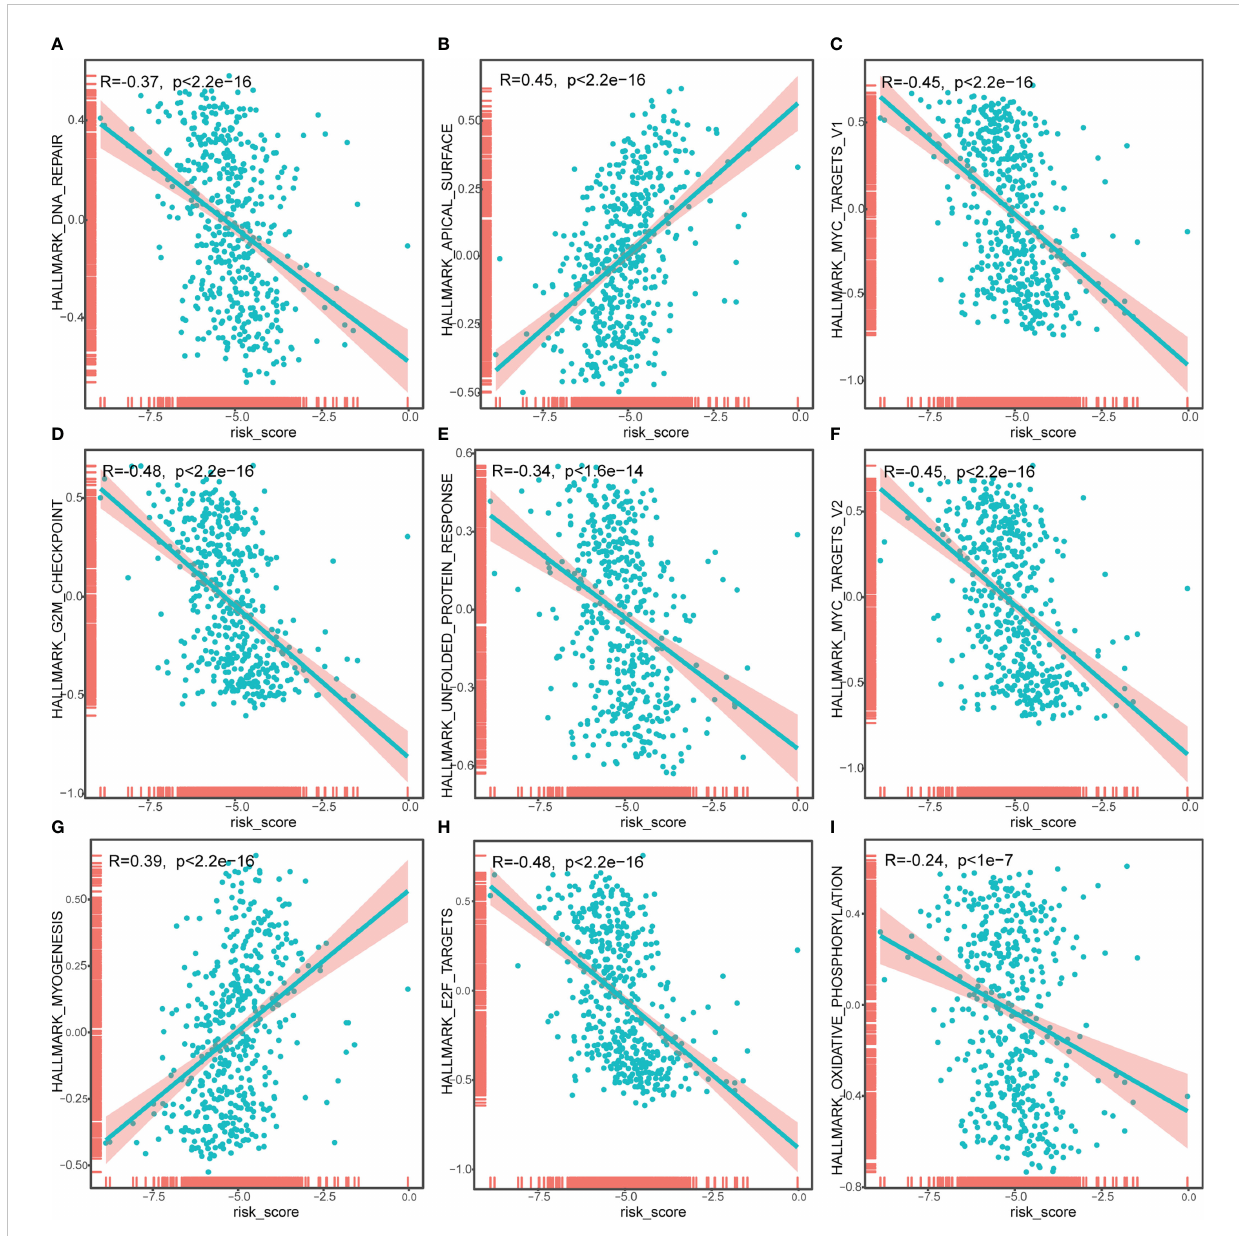
FIGURE 7 Correlation analysis of risk score and Hallmark_DNA_repair (A) , Hallmark_APICAL_surface (B) , Hallmark_myc_targets_v1 (C) , Hallmark_G2M_checkpoint (D) , Hallmark_unfolded_protein_response (E) , Hallmark_myc_targets_v2 (F) , Hallmark_myogenesis (G) , Hallmark_E2F_targets (H) , Hallmark_oxidative_phosphorylation (I) . The horizontal axis represents the risk score, and the vertical axis represents the enrichment score of the